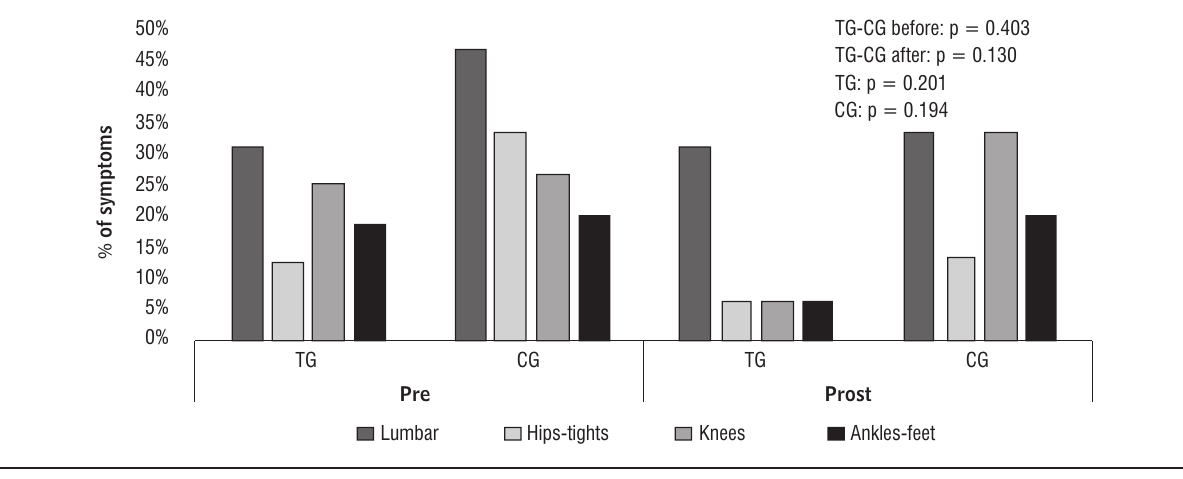
Figure 3 – Relative frequencies of symptoms in different body regions of the teachers from the TG and the CG group Note: TG-CG before = intergroup analysis before training; TG-CG after = intergroup analysis after training; TG = intra-group analysis; CG = intra-group